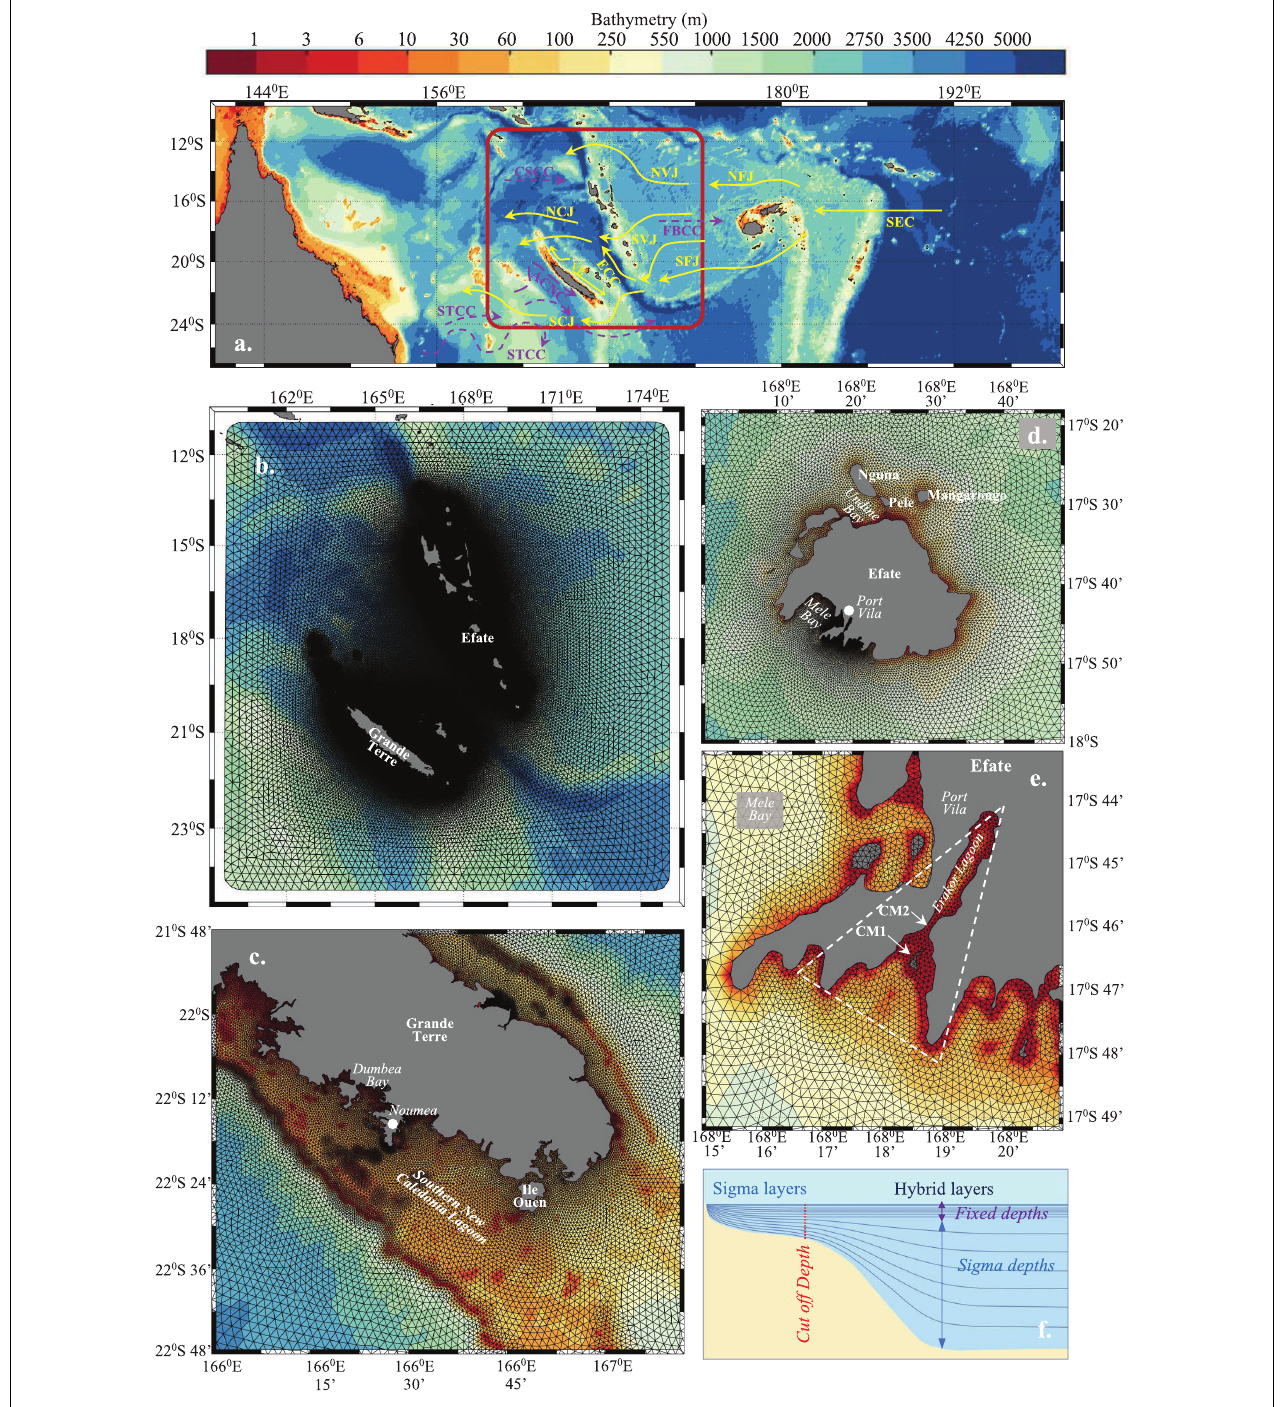
FIGURE 1 | Site map and bathymetry of the ocean region investigated, covering the Vanuatu and New Caledonia archipelagos (a) . The model domain extent is shown highlighted in the dark red rectangle. Yellow arrows represent regional currents associated with the passage of the Southern Equatorial Current (SEC) through the archipelagos and purple dashed arrows represent counter currents in the region. Indicated are the North/South Fiji Jets (NFJ/SFJ), North/South Vanuatu Jets (NVJ/SVJ), North/South Caledonia Jets (NCJ/SCJ), East Caledonia Current (ECC), the Vauban Current (VC), the SubTropical Counter Current (STCC), Coral Sea Counter Current (CSCC), Alis Current of New Caledonia (ACNC), and the Fiji Basin Counter Current (FBCC). The Van-Fvcom model grid constructed for the study (b) overlying bathymetry. Excerpts of the Van-Fvcom model grid covering southern Grande Terre (c) , Efate Island (d) and Erakor Lagoon, Efate Island (e) overlying bathymetry. Erakor Lagoon is highlighted in the dashed white triangle (e) . The legend shown at the top of the figure applies to panels (a–e) . Visual description of the hybrid vertical layer system employed by the Van-Fvcom model (f) .